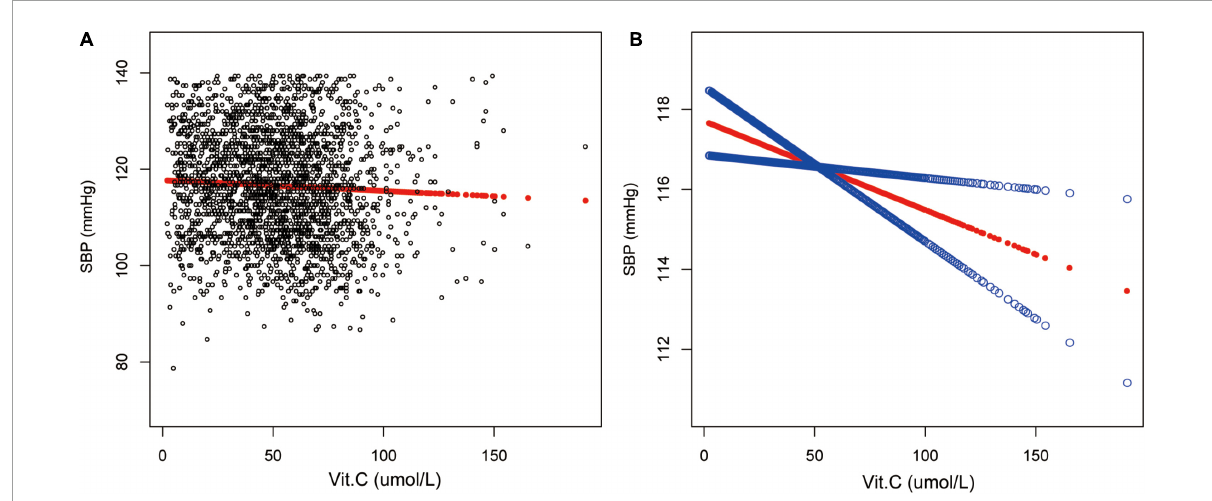
FIGURE2 Relationship between vitamin C and SBP. (A) Each black point represents a sample. (B) The red line represents the smooth curve fit between variables. In comparison, blue bands represent the 95% CI. Sex, age, race/ethnicity, marital status, education level, ratio of family income to poverty, BMI, smoking states, pulse, ALT, ALP, AST, BUN, globulin, Cr, TG, TC, LDL, HDL, glycohemoglobin, TP, FBG, γ GT and sUA were adjusted.